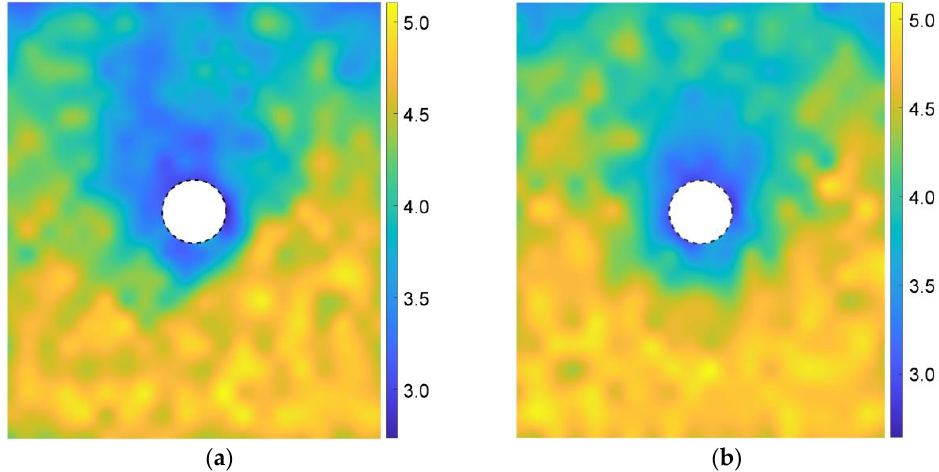
Figure 23. Distribution of coordination numbers of the ground after the tunnel excavation in the cases of ( a ) AR4C3 and ( b ) AR6C3.